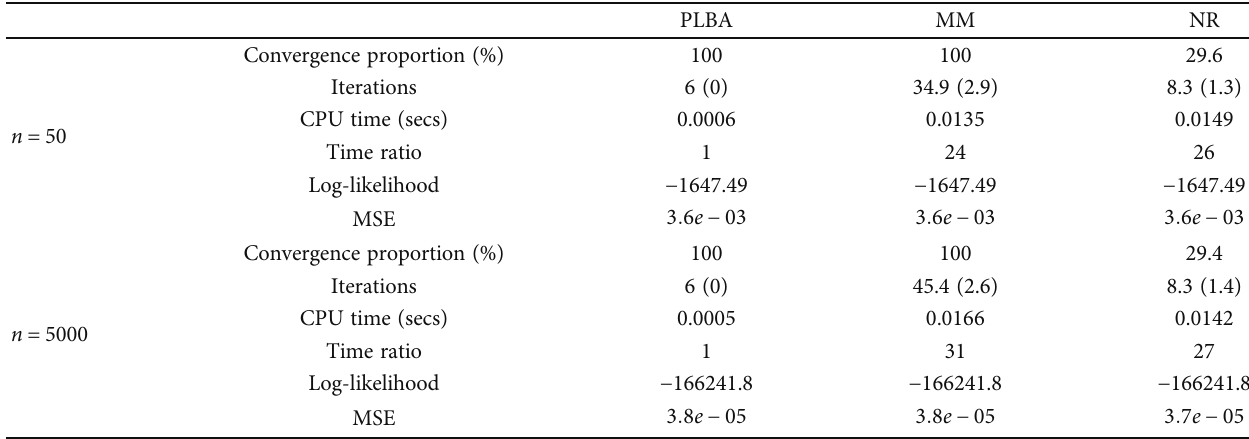
Table 5: Results for Scenario 4 (values in brackets are standard